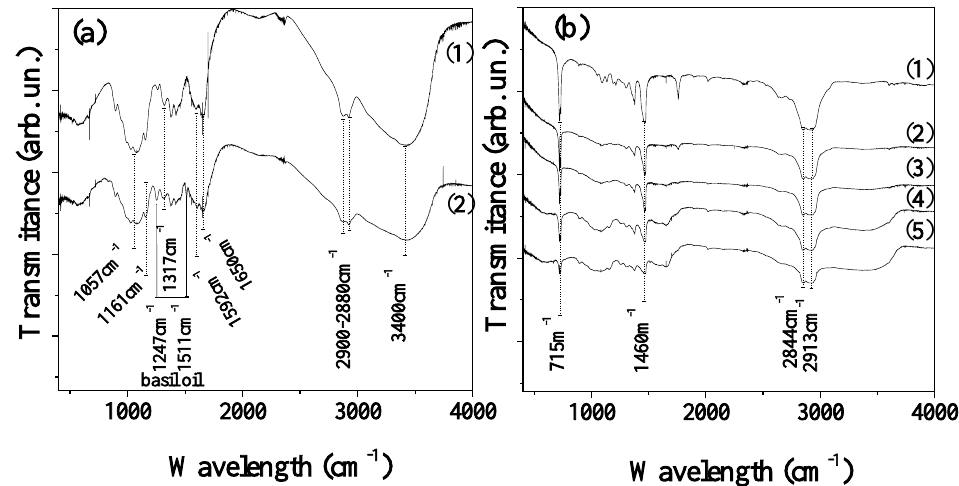
Figure 2. ( a ) FTIR spectra of (1) neat CS, and (2) CS_BO hybrid blend, ( b ) FTIR spectra of (1) neat LDPE, (2) LDPE/CS_BO5, (3) LDPE/CS_BO10, (4) LDPE/CS_BO20, and LDPE/CS_BO30 films.